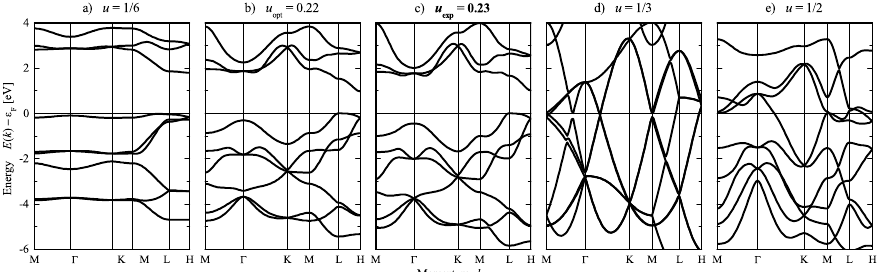
Figure 15. Electronic structure of chiral and achiral ( u = 1/3) Se. The band structures are calculated for variation of the chirality by changing the position parameter u . From left to right: ( a ) u = 1/6 ( S 2 = 100%), ( b ) u = 0.22 (optimized) ( S 2 = 45.2%), ( c ) u = 0.23 (experiment) ( S 2 = 38.4%), ( d ) u = 1/3 ( S 2 = 0), ( e ) u = 1/2 ( S 2 = 100%). The corresponding chirality measures are given in brackets (compare also Figure 5). Note that the parameters u = 1/3 ( R 3 m ) and u = 1/2 ( P 6 4 22) result in different space groups and symmetry. Calculations are for variation of the position parameter at optimized lattice